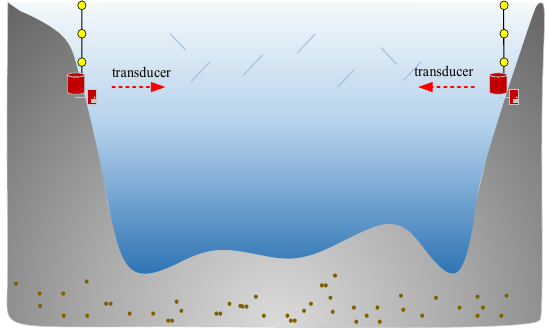
Figure 1. Diagram of reciprocity transmission of acoustic tomography.